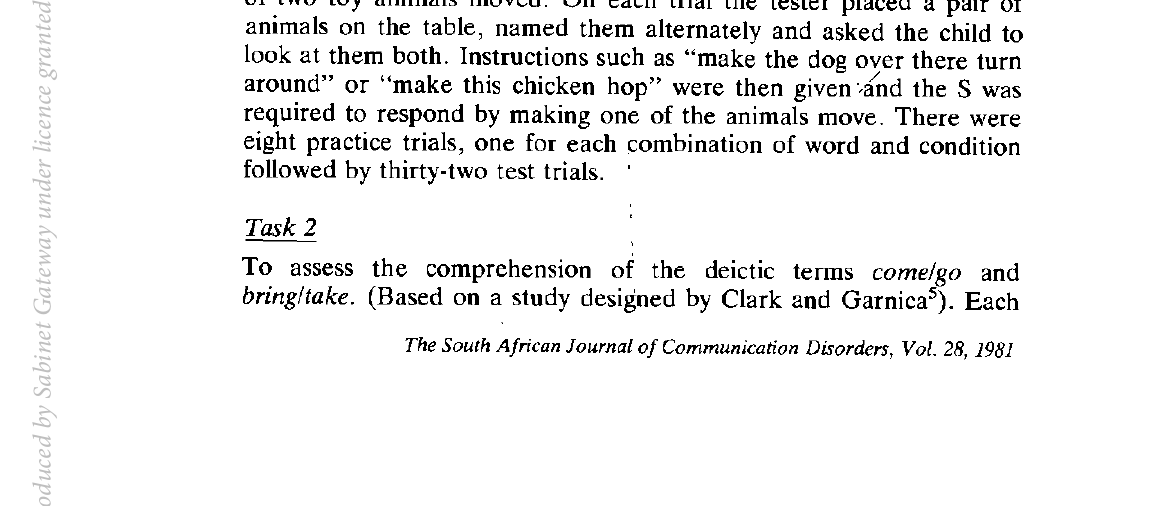
Figure lb: Testing Situation used for Task 1: Condition b One pair of identical toy animals was placed on the table for each